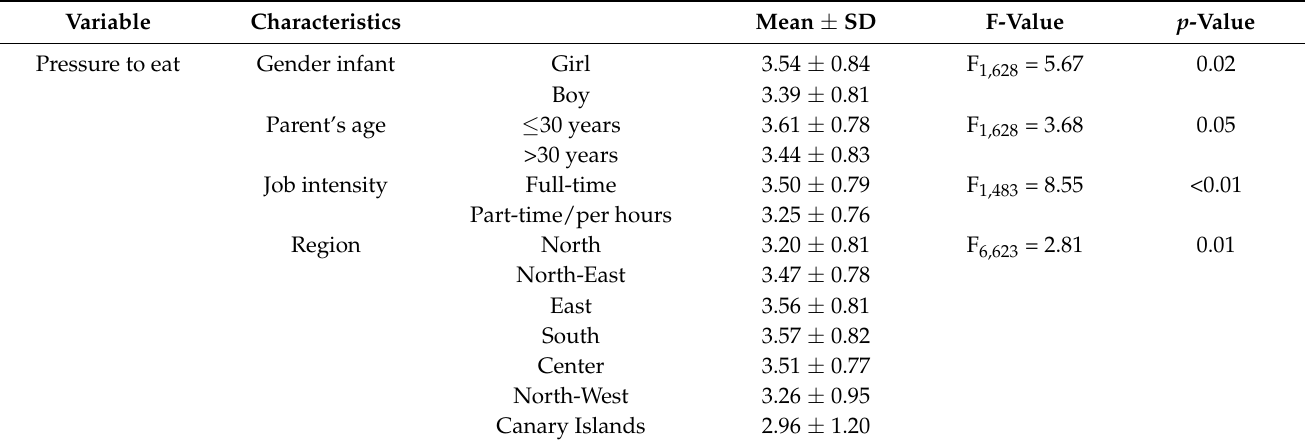
Table 5. One-way ANOVA testing for the effects of sample characteristics on the pressure to eat. Only significant results are